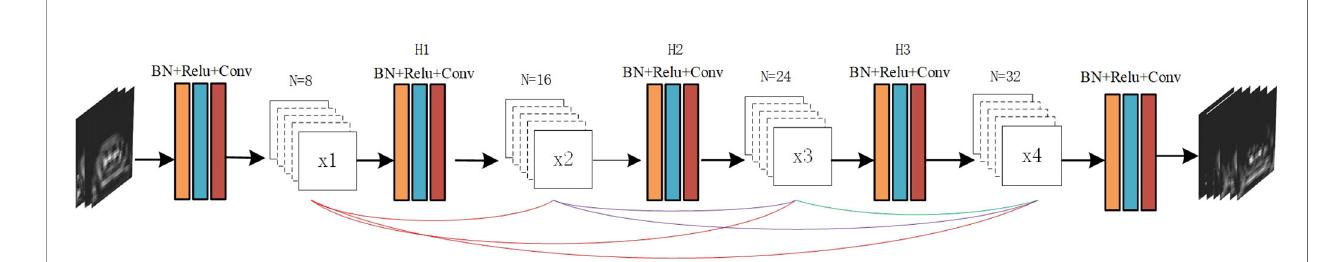
FIGURE 3 | Scheme of dense block.